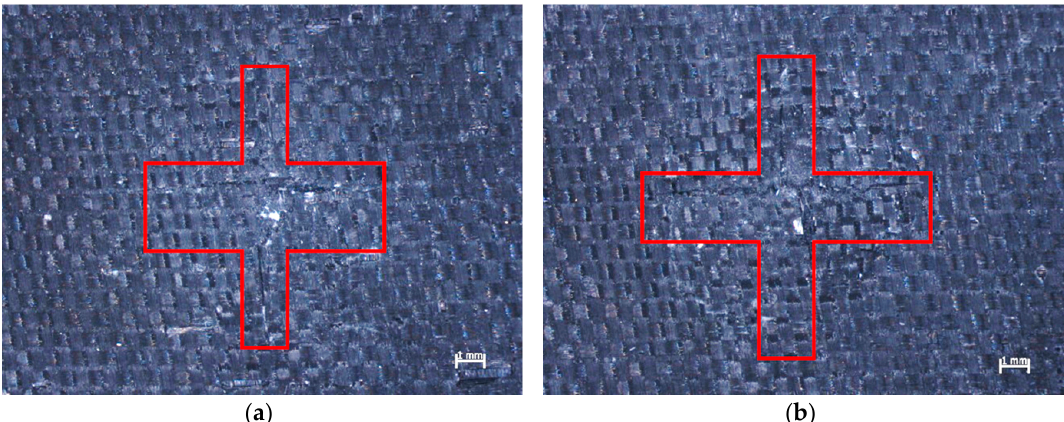
Figure 7. Epoxy composites reinforced by Pyrofil TR30 S fibers after impact from: ( a ) conical striker, ( b ) ogival striker—view from the opposite side to the impact side.